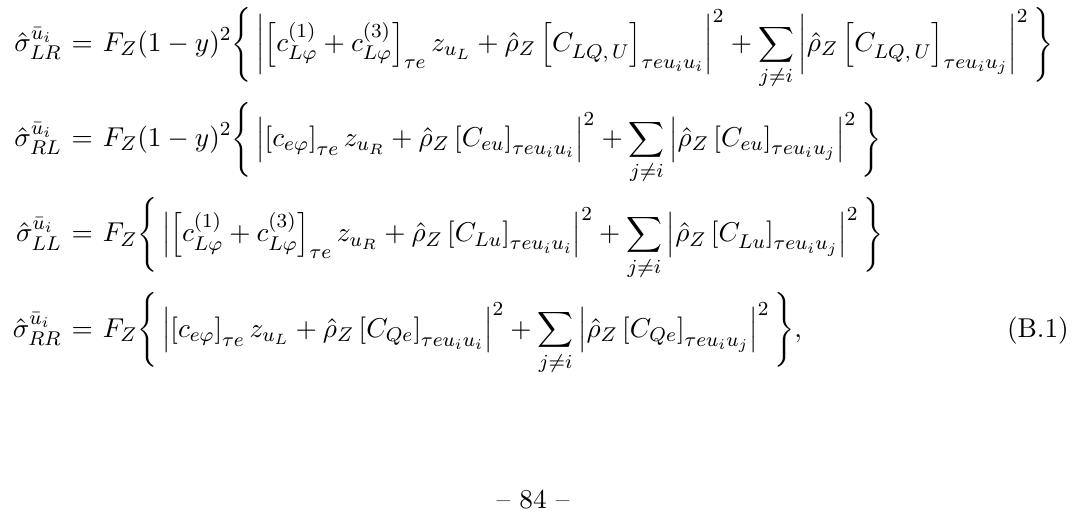
] , [ C ee ] and [ C ee ] are eeτe µµτe µeτµ VLL VLL VLL